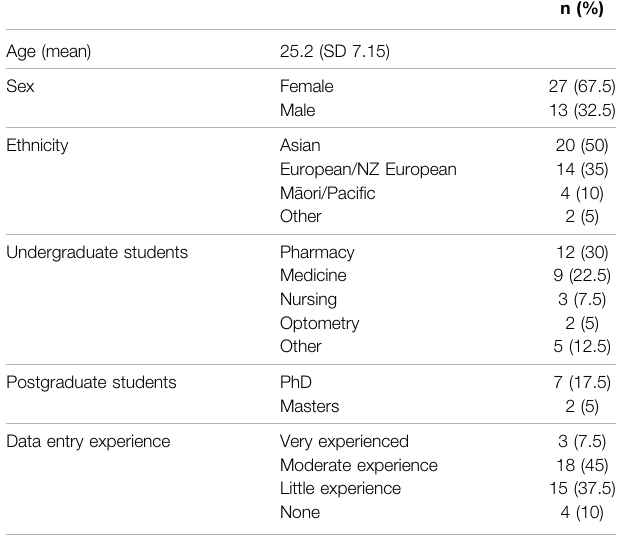
TABLE 1 | Study I participant demographics (N = 40).